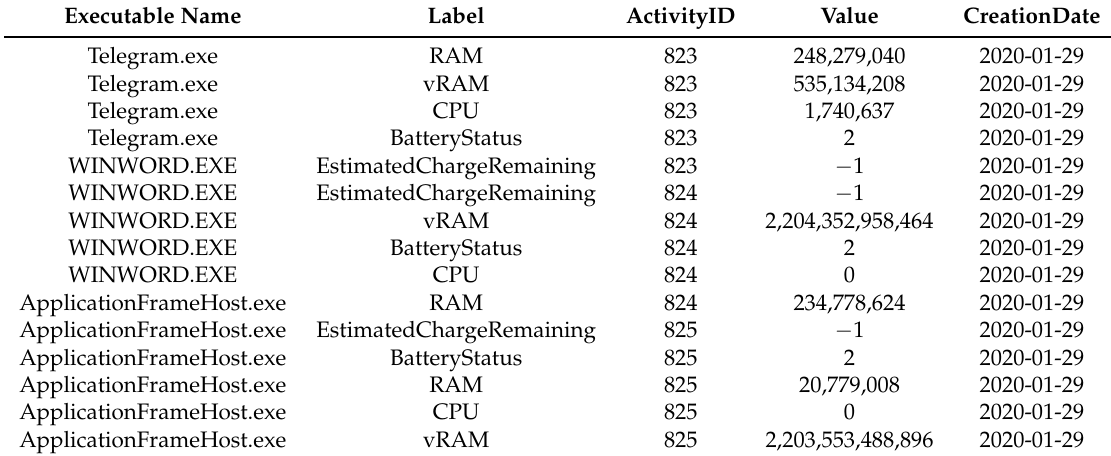
Table 1. Processes and their resource